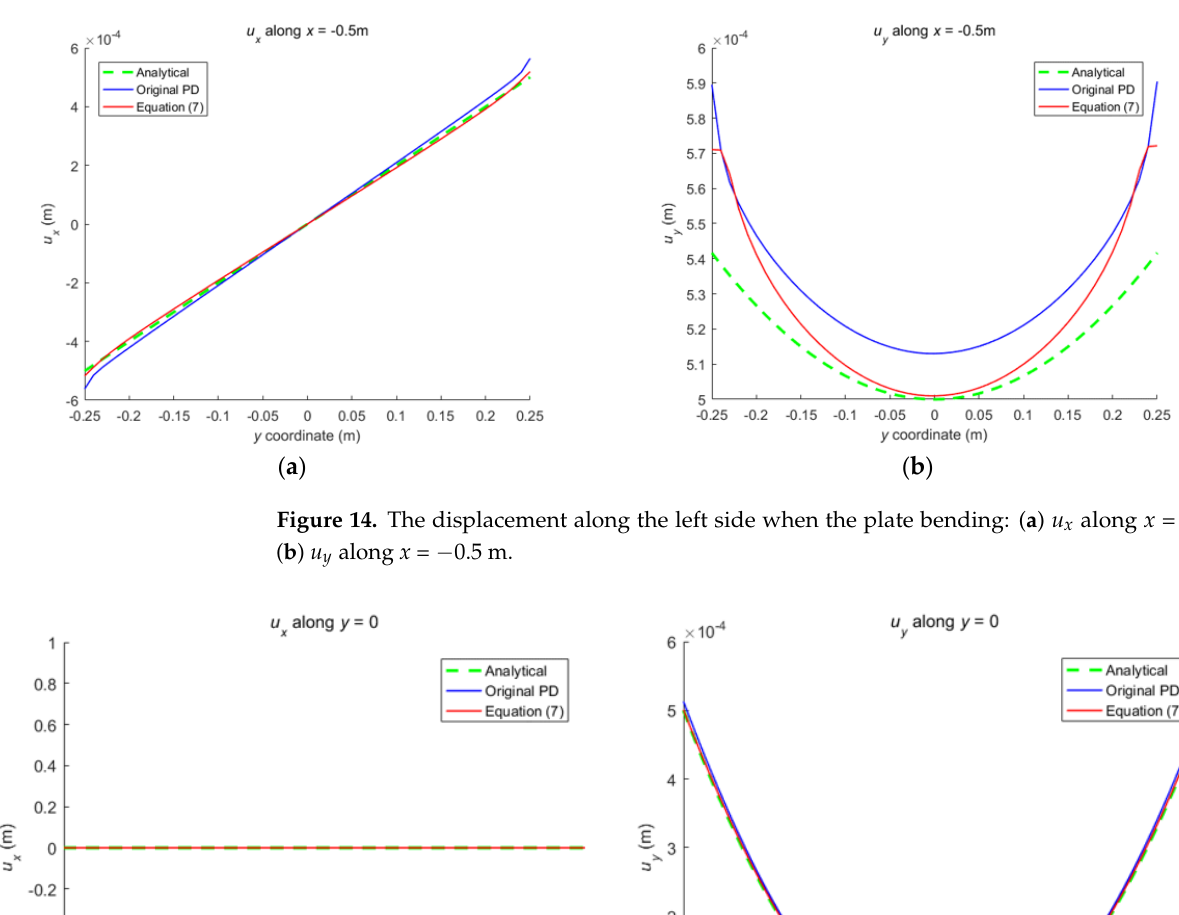
Figure 13. The displacement along the bottom side when the plate bending: ( a ) u x along y = − 0.25 m; ( b ) u y along y = − 0.25 m.